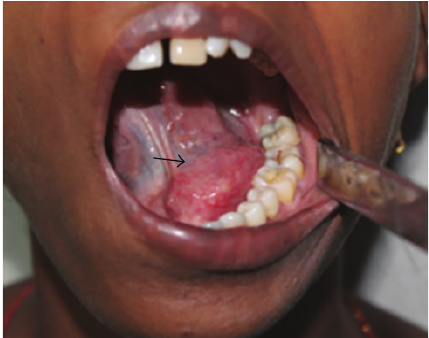
Figure 1: Intraoral view of well-circumscribed swelling (black arrow) in the left floor of the mouth.